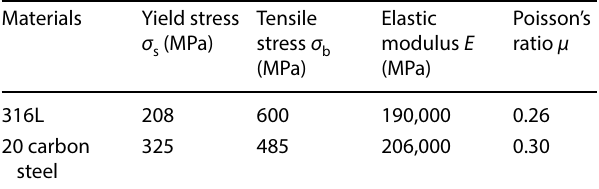
Table 2 Mechanical property of pipe